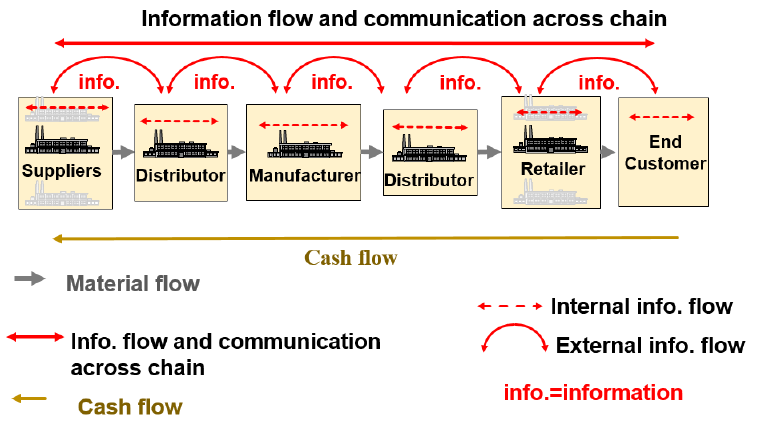
Figure 2. Three major flows through the value